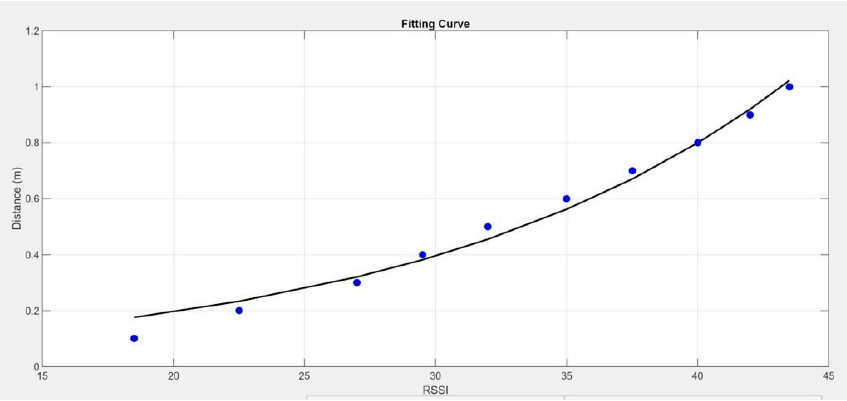
Figure 12. Code sections for RSSI and distance calculation.